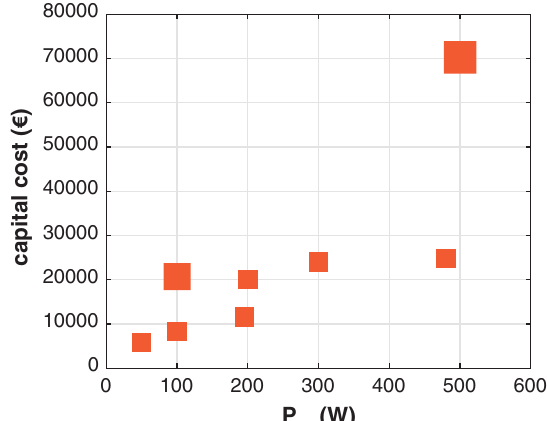
Figure 12. Capital costs of TEGs. Markers of bigger size identify TEGs models suited to operate in potentially explosive